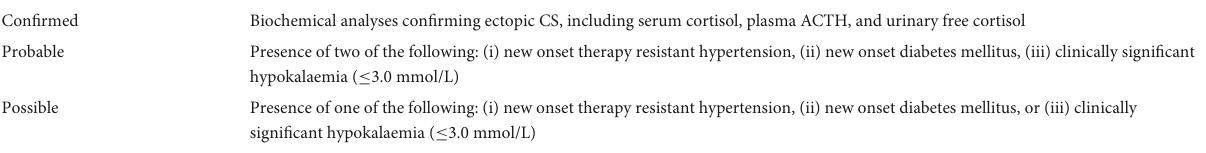
TABLE 1 Definitions of confirmed, probable and possible ectopic Cushing’s syndrome used in this study. Confirmed Probable